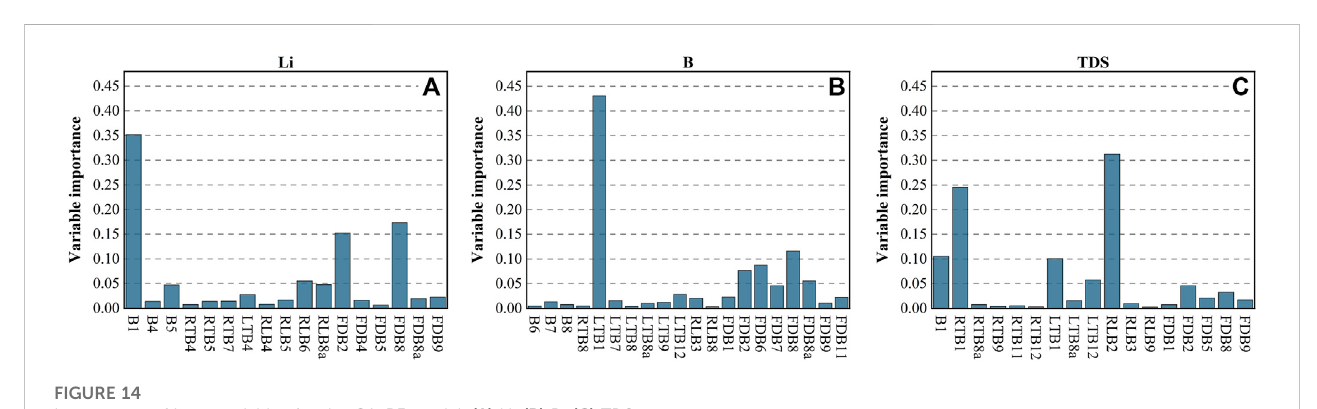
FIGURE 14 Importance of input variables for the GA-RF model. (A) Li; (B) B; (C)